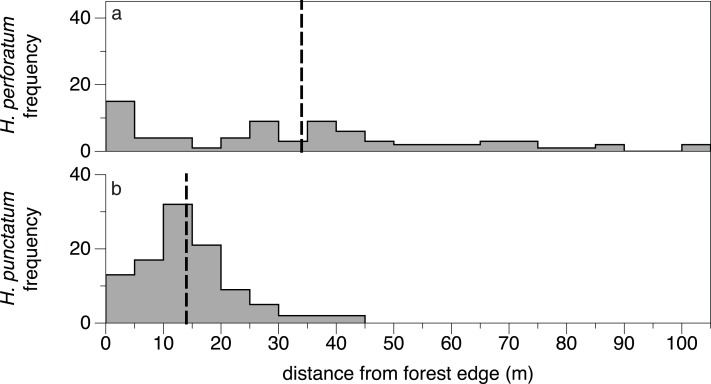
Natural distribution of exotic H. perforatum (A) and native H. punctatum (B) in the field.The former occurs throughout fields, while the latter is concentrated in shadier areas less than 20 m from the forest edge and does not occur more than 40 m from the forest edge. Dashed lines indicate the mean distance from forest edge for each species.